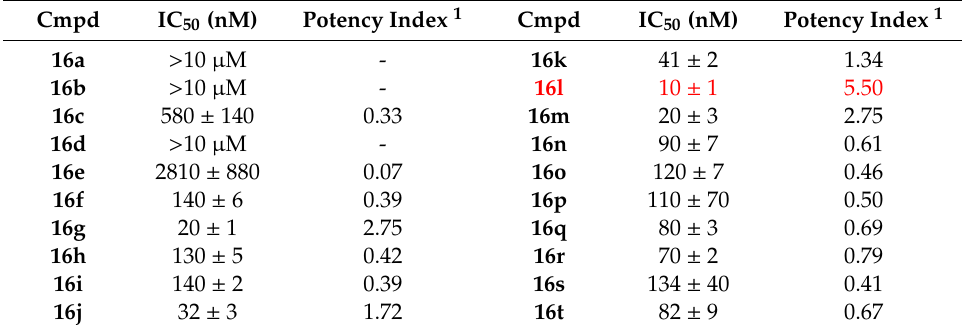
Table 2. Inhibition of Ee AChE by pyranotacrines 16a – t (data from [71,78,79]). Cmpd IC 50 (nM) Potency Index 1